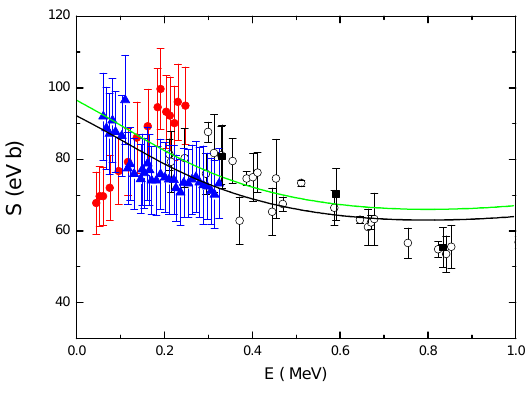
Figure 2. The experimental and calculated astrophysical S-factor for the radiative-capture 6 Li( p ,γ ) 7 Be reaction (fig.7 of ref.[33]). The solid green line is the direct component of the astrophysical S factor, obtained using the weighted average ANC values from the near-barrier proton transfer 6 Li( 3 He, d ) 7 Be = 3 and 5 MeV. The black line is the S factor obtained from the ANCs deduced from the reaction at E 3 He analysis of 6 Li( p ,γ ) 7 Be directly measured reaction [44]. Blue solid triangles represent the bare-nucleus astrophysical factor from ref.[44] (including systematic error), red filled circles are the experimental astrophysical factor published in [45], empty circles are taken from [46] and black solid squares from